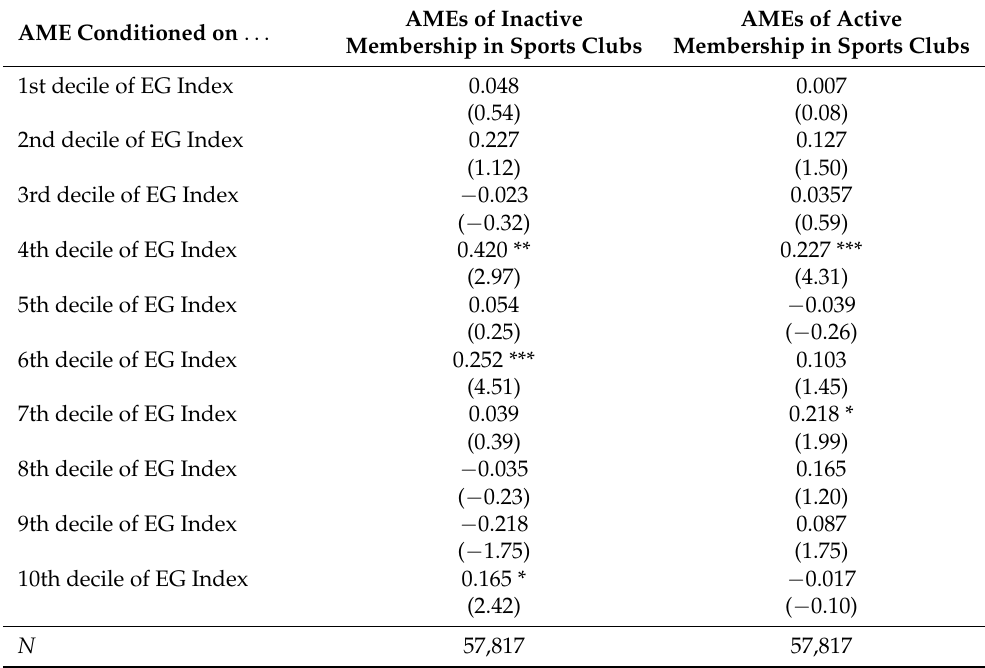
Table A5. Average marginal effects (AMEs) from inactive and active membership in sports clubs on sexist gender ideologies conditioned on the EG Index. Results for the group of men. We included 95% confidence intervals using robust standard errors. Source: WVS-EVS-data and V-Dem data. AME Conditioned on . . .